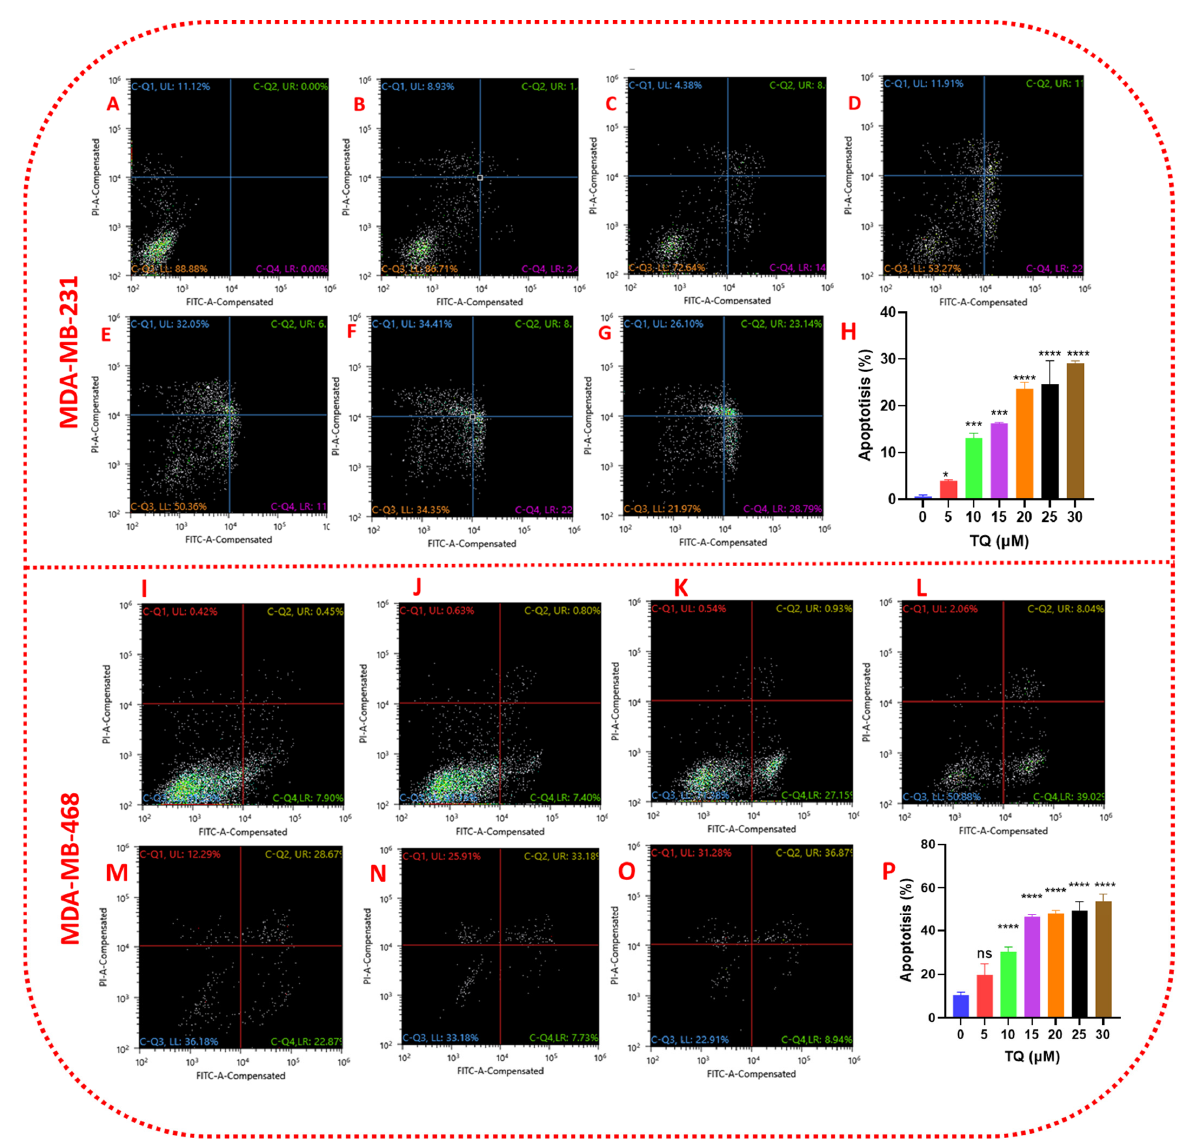
Figure 8. TQ induces apoptosis in TNBC cells. The apoptotic effect of TQ in TNBC cell lines is shown in Figure 8 ( A – H ) (MDA-MB-231) and ( I – P ) (MDA-MB-468). TQ was applied to both cell lines for 24 h at concentrations ranging from 0 to 30 µM. An experimental medium with DMSO was used to treat the control cells. A Sony SH800 cell sorter was used to evaluate the percentage of apoptotic cells in TQ-treated samples as well as the control, and an Annexin V-FITC apoptosis kit was utilized to mark treated/control cells. The mean ± S.E.M. of three independent investigations with n = 3 each is shown by each data point in the bar graphs. After TQ treatment, the percentage of apoptotic and necrotic cells increased, while the percentage of viable cells decreased. Using one-way ANOVA and Bonferroni’s multiple comparisons test, the significance of the difference between control and each treatment was assessed. The statistically significant differences were shown by, * p < 0.05, *** p < 0.001, and **** p < 0.0001, ns,